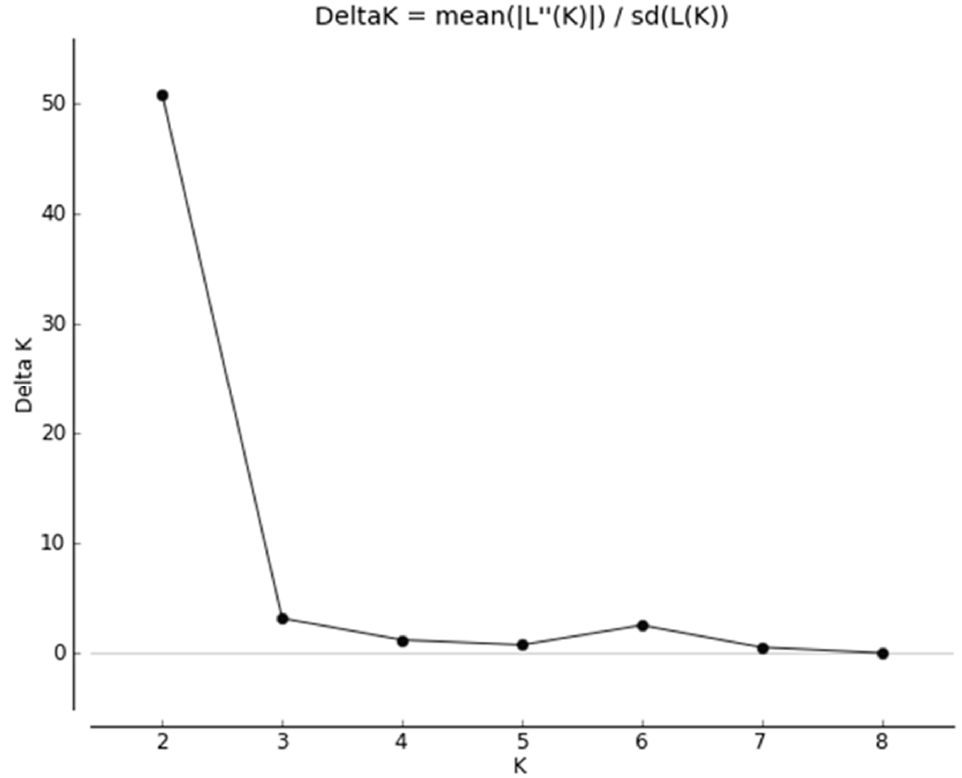
Figure 2. Results from Structure Harvester analysis to reveal the most likely value of K based on the STRUCTURE results.